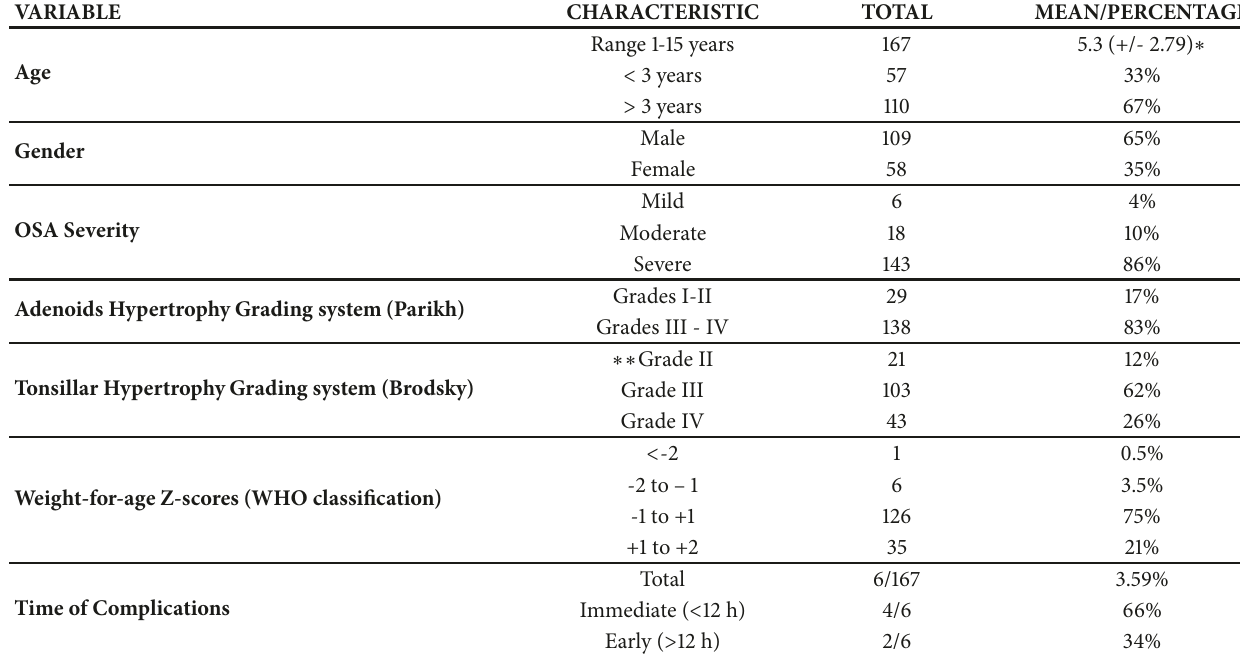
Table 1: Demographic characterization of all patients undergoing adenotonsillectomy for OSA indication.